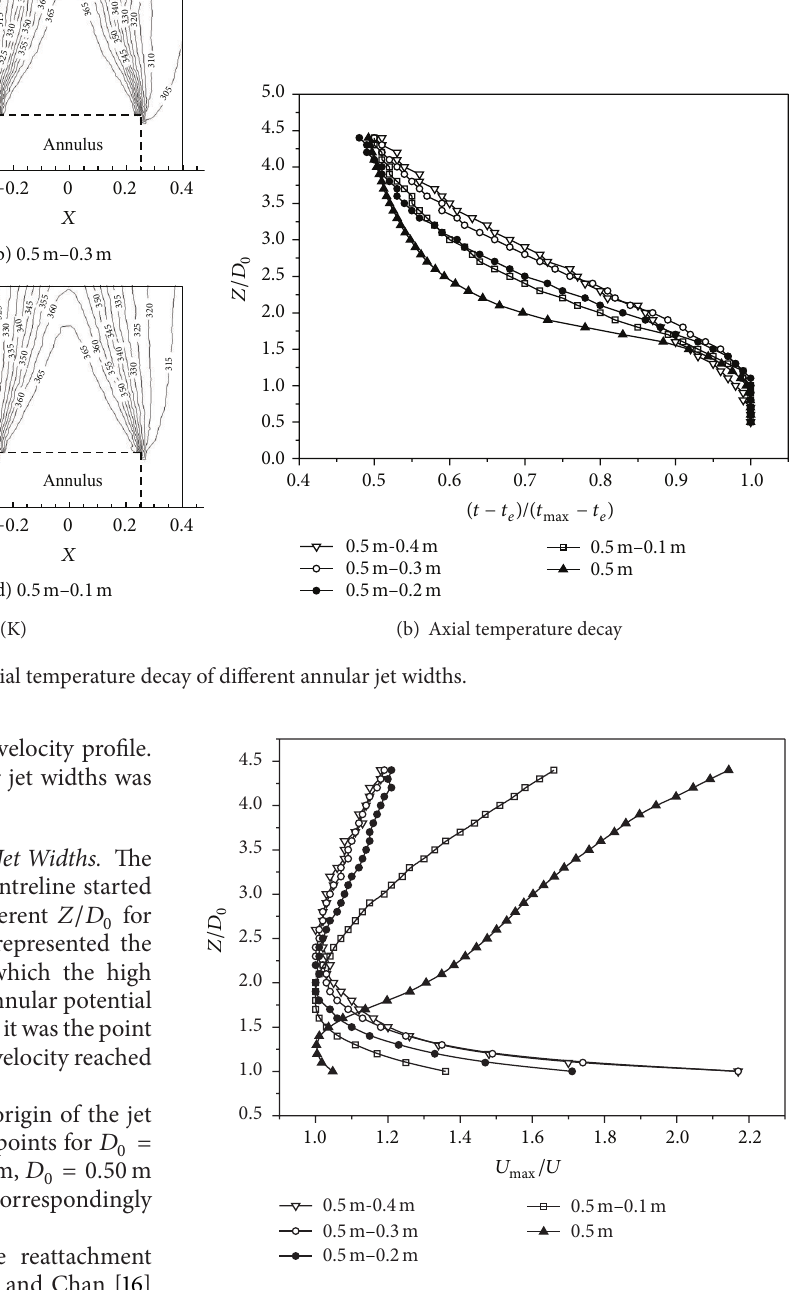
Figure 6: The reattachment point of different annular jet